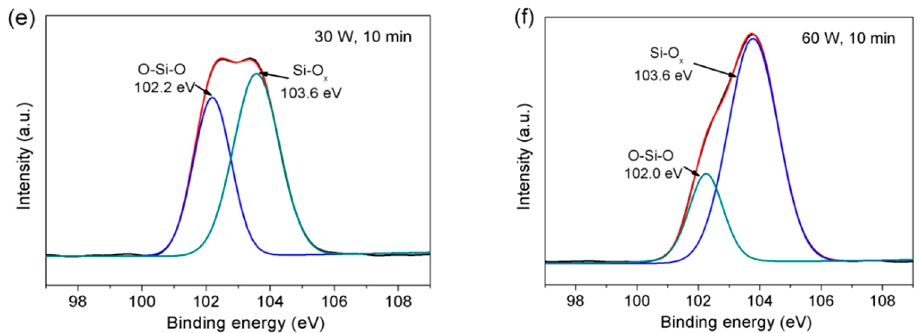
Figure 4. ( a ) General XPS spectra of samples before and after CO 2 plasma treatment. High-resolution C1s XPS spectra of samples before ( b ) and after CO 2 plasma treatment ( c ). High-resolution Si 2p XPS spectra of samples before ( d ) and after plasma treating for 10 min at 30 W ( e ) and 60 W ( f ). Table 3. Surface elemental composition of pristine PDMS and CO 2 plasma treated PDMS. Samples